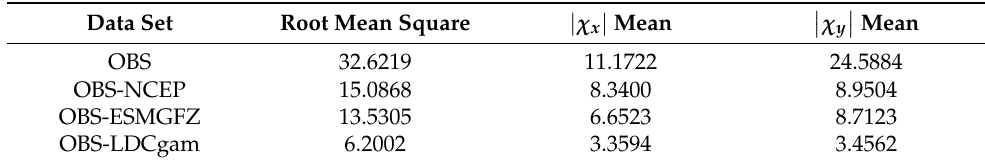
Figure 8. The x- and y-components of unexplained polar motion excitations for the NCEP, ESMGFZ and LDCgam data sets, respectively. Table 2. Statistics of relevant time series (Unit: